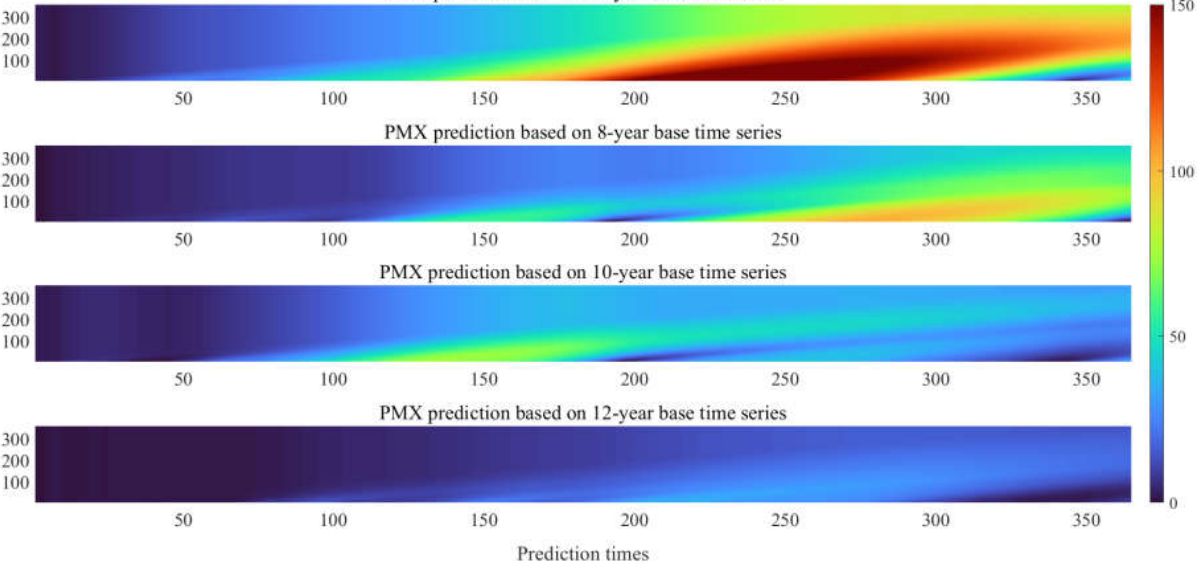
Figure 9. MAE (unit: mas) of PMY prediction using hybrid CNN–LSTM model based on different base time series. 5. Conclusions Earth rotation parameters play a crucial role in high-precision timing services, pre- cise orbiting of artificial satellites, etc. Prior studies have noted the importance of esti- mating and predicting ERP. We obtained the ERP series by estimating VLBI observa- tions from 2011 to 2020 for IVS-R1/R4 sessions; furthermore, the CONT08, CONT11, CONT14, and CONT17 observations were estimated. The results show an average RMSE of 0.187 and 0.205 mas for PMX and PMY, respectively, and accuracy of 0.022 ms for UT1-UTC based on IVS-R1/R4 solutions. The accuracy of polar motion for CONT solu- tions was in the range of 0.03–0.05 mas, and for UT1-UTC based on the CONT solutions it was 0.005–0.01 ms.